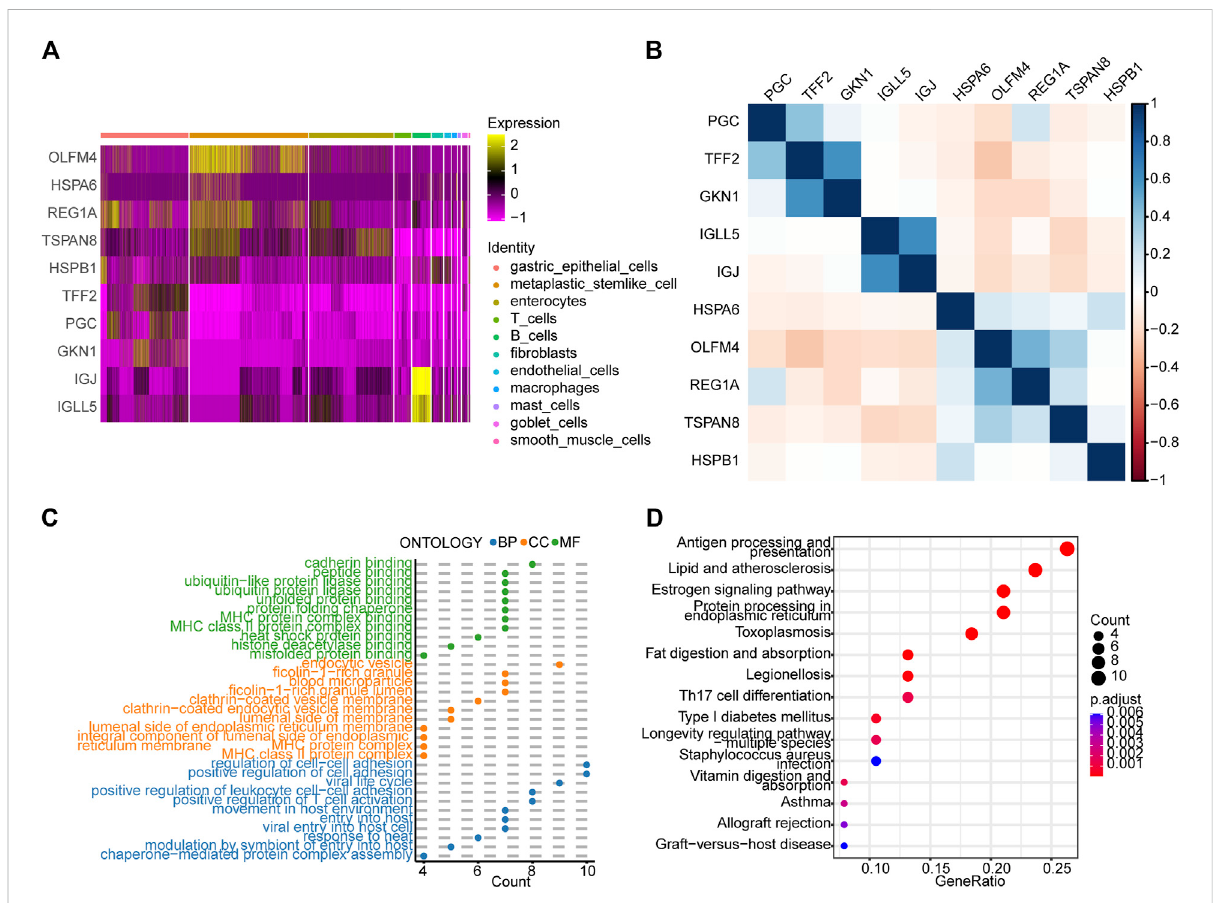
FIGURE 3 Analysis of differences between the early gastric cancer (EGC) and intestinal metaplasia (IM) groups and subsequent enrichment analyses. (A) Heatmapshowingtheexpressionpatternsoftendifferentiallyexpressedgenes(DEGs)betweentheEGCandIMgroupsinthedifferentcelltypes. (B) Heat map of the correlation between the DEGs. Dot plots showing the (C) GO and (D) KEGG pathway enrichment analyses of the DEGs ( p -value < 0.01). BP, biological process; CC, cellular component; MF, molecular